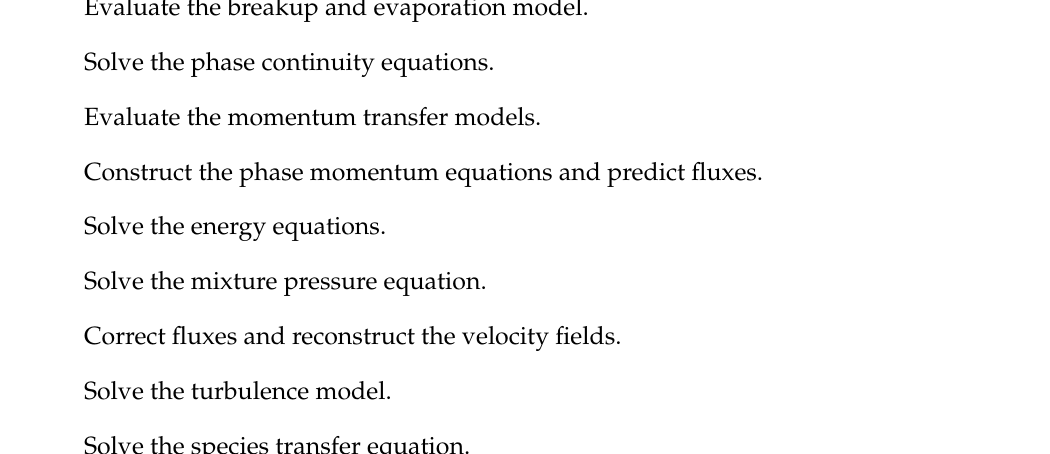
Algorithm 1 Employed solution procedure for each time